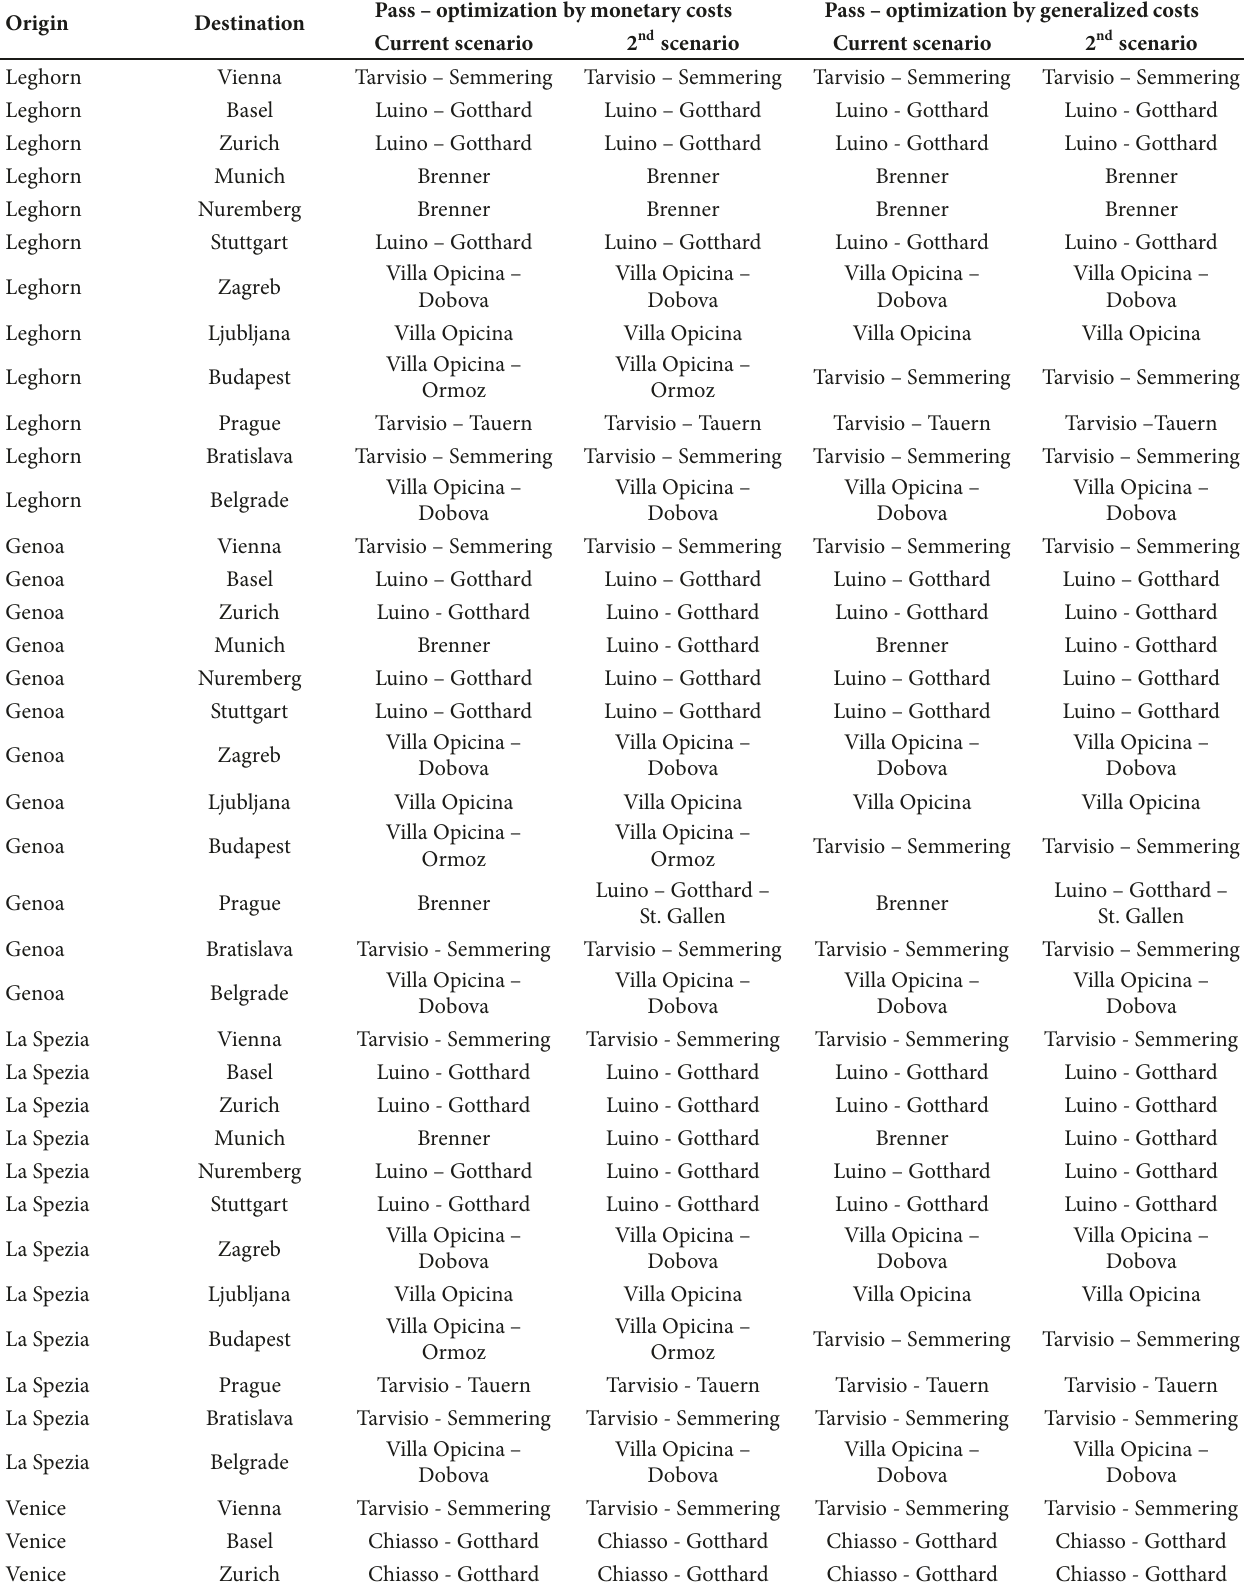
Table 11: Railway lines crossing the Alps used to connect the considered O/D pairs. The 2 nd sensitivity scenario (called in the table briefly “ 2 nd scenario”) is compared with the current one. Only O/D pairs which require the crossing of Alpine passes have been taken into